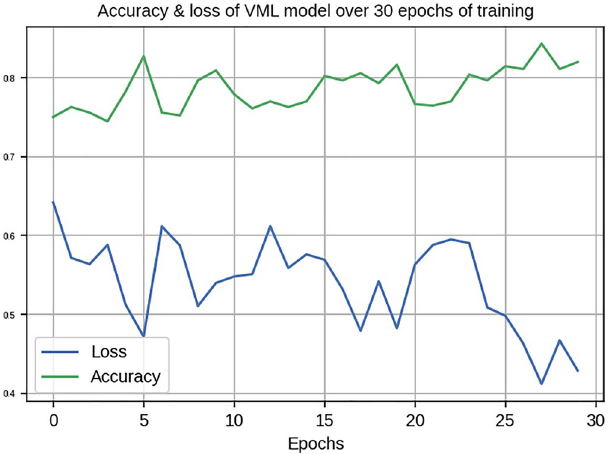
Figure 4. Accuracy and loss (error rate) of the VML over 30 epochs of training (Figure generated by Matplotlib python library, version 3.3.4, https:// matpl otlib. org/).